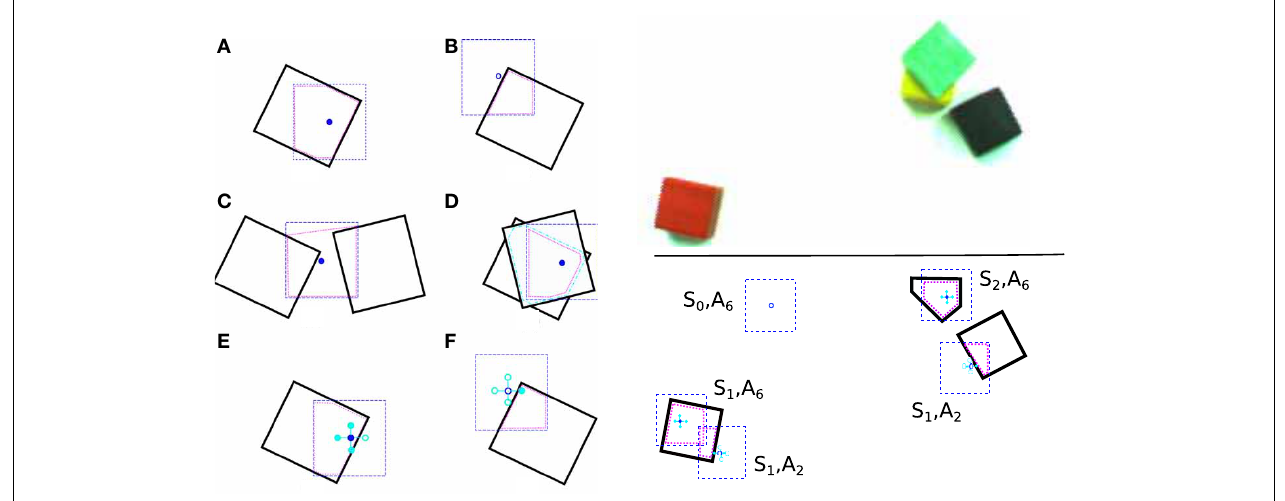
FIGURE 2 | Left: (a–f) Examples illustrating the features that were used. Right: An example showing how the state and action are encoded (bottom) for a given blocks-world setting (top). See text for details.